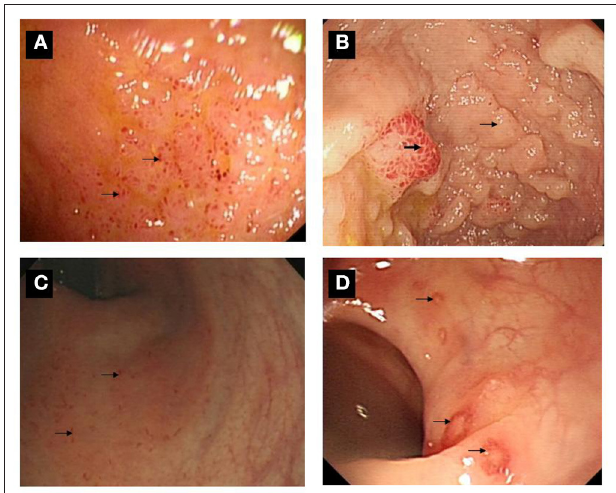
FIGURE 3 | Ileo-colonoscopic pictures of gut inflammation among SpA patients. (A) Multiple lesions were over the surface in the terminal ileum. (B) A sign of mucosal nodularity (small arrow) with hyperemia-like changes was in terminal ileum (bold arrow). (C) Multiple small lesions were found over the surface of rectum and sigmoid colon (arrow). (D) Multiple ulcers were found over the surface of descending, sigmoid colon and rectum (arrow).